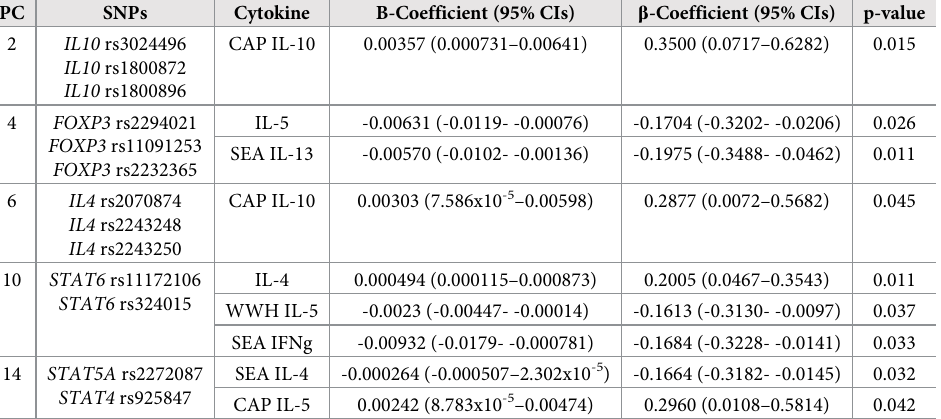
Table 6. Multiple linear regression of cytokine concentrations and